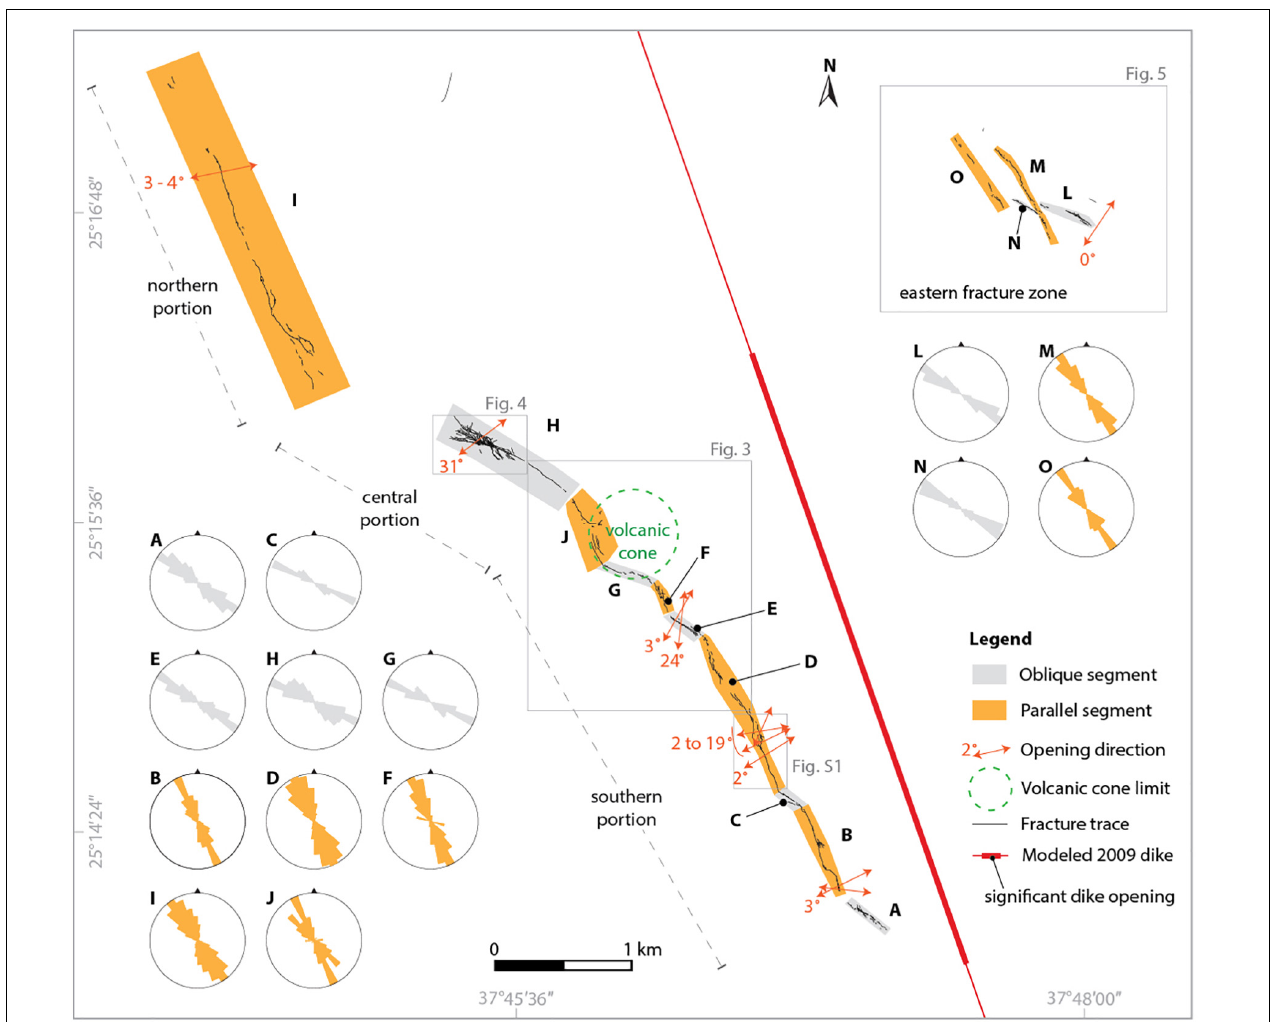
FIGURE 2 | Surface fractures (normal faults and open fractures; black lines) mapped from using the high-resolution drone dataset. Dike parallel (orange) and oblique (light gray) segments are highlighted and labeled with capital letters. Corresponding rose diagrams show the frequency of fracture orientations in each segment. See Table 1 for more